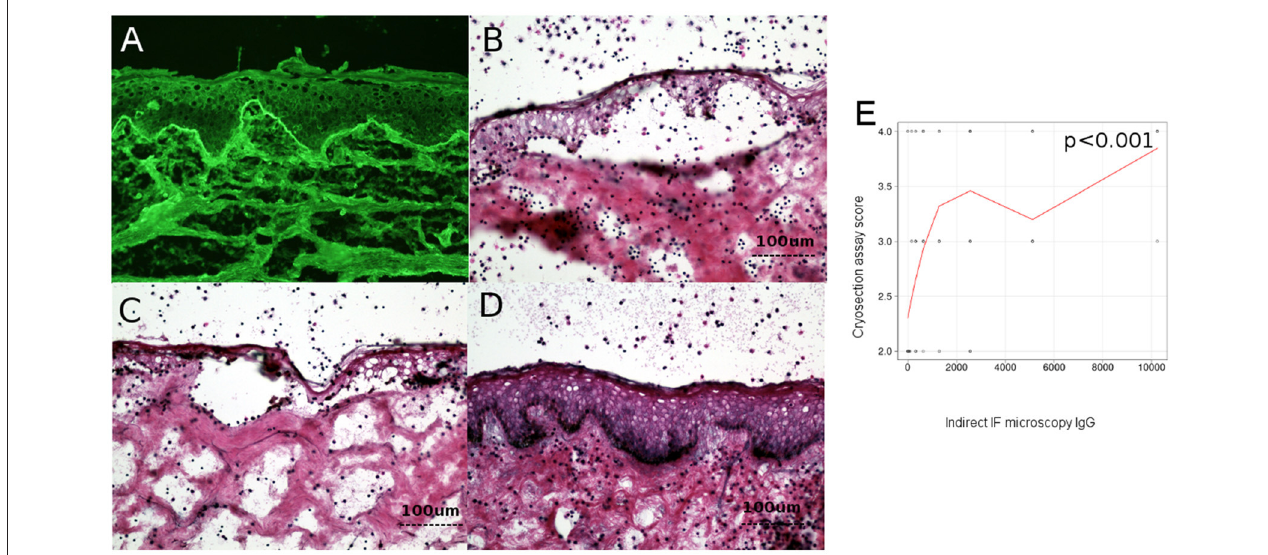
FIGURE 3 | Level of circulating IgG anti-basement membrane zone autoantibodies correlates with dermo-epidermal separation in patients with bullous pemphigoid. (A) Indirect immunofluorescence microscopy on normal human foreskin, using BP patient sera. (B,C) Cryosection assay ex vivo of normal human foreskin, incubated with a BP serum pool (B) and BP serum from a patient (C) . Subsequent addition of normal human leukocytes leads to recruitment of neutrophils at the dermal-epidermal junction. Activation of neutrophils is induced by BP serum, leading to dermal-epidermal split. (D) Cryosection assay ex vivo of normal human foreskin, incubated with serum from healthy donors. Subsequent addition of normal human leukocytes does not lead to recruitment or activation of neutrophils at the dermal-epidermal junction and does not induce dermal-epidermal split. ( E) Relation of titers of circulating IgG anti-basement membrane zone autoantibodies with dermal-epidermal separation in patients with bullous pemphigoid ( n = 90). The red line represents the locally weighted scatterplot smoothing